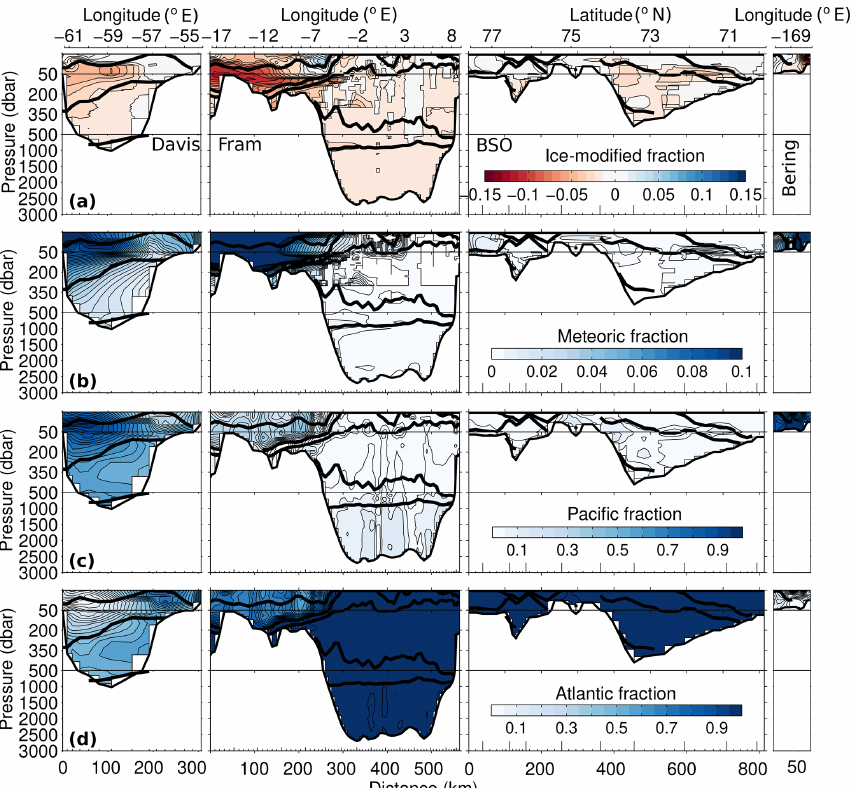
Figure 7. Sections of ice-modified fraction (a) , meteoric fraction (b) , Pacific fraction (c) and Atlantic fraction (d) , for the 4EM model, clockwise around the four gateways from Davis Strait to Bering Strait. Solid black lines indicate the isopycnal surfaces separating the main Arctic water masses as described in Tsubouchi et al. (2012). End members used were the mean of the literature values (see Tables 2 and 3). Note different colour scales for each panel. Table 6. Mean volume fluxes (Sv ± standard deviation) for the four-end-member (4EM) model. Positive values indicate fluxes into the Arctic. Values of solid freshwater flux from Tsubouchi et al. (2012). Atlantic Pacific Met. Ice melt